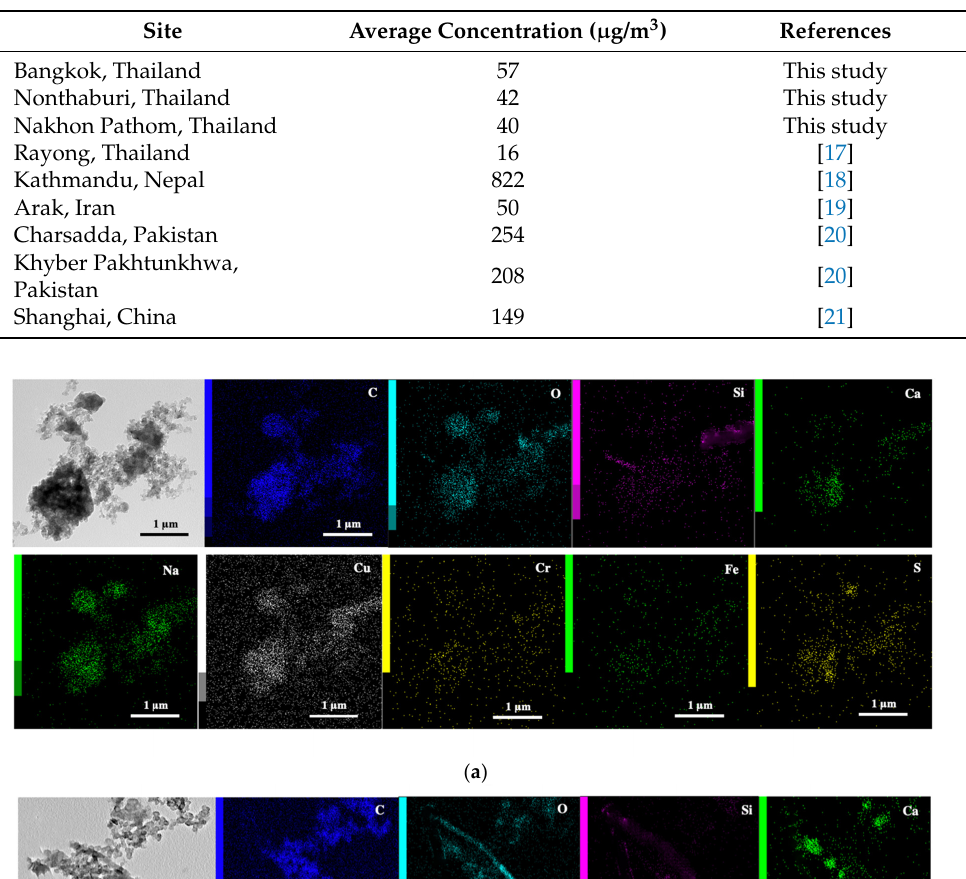
Table 1. Average ambient concentrations of PM10 in other locations.